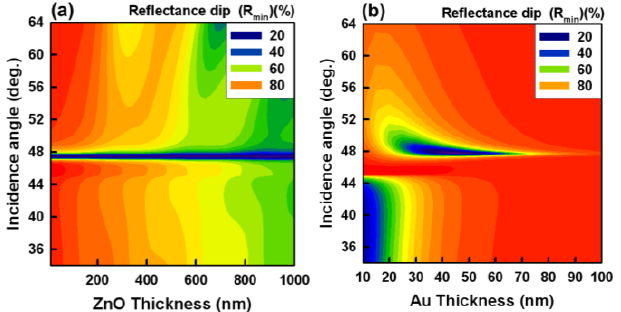
Figure 4. ( a ) Theoretically calculated (symbols) and measured (solid lines) reflectance SPR spectra of devices at a wavelength of 830 nm in below water. ( b ) Measured (solid lines) vs . theoretically calculated (symbols) transmittance spectra of fabricated devices, in water. ( c ) Intensity of the electric field (V/m) amplitude through the dielectric structure when the incident angle is the SPR angle. The plasmon electric field intensity is the highest with maximum coupling of the incident excitation light at a wavelength of 830